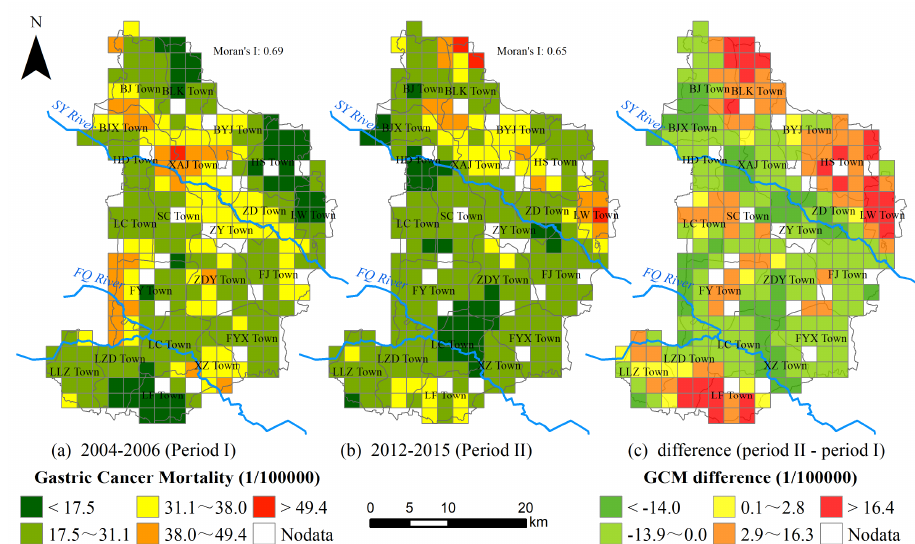
Figure 4. Spatial variation of GCM. ( a ) GCM spatial pattern in period I; ( b ) GCM spatial pattern in period II, the Moran’s I is significant at 0.01 level; ( c ) the GCM difference between period I and period II (the grid without villages points were not taken into account).